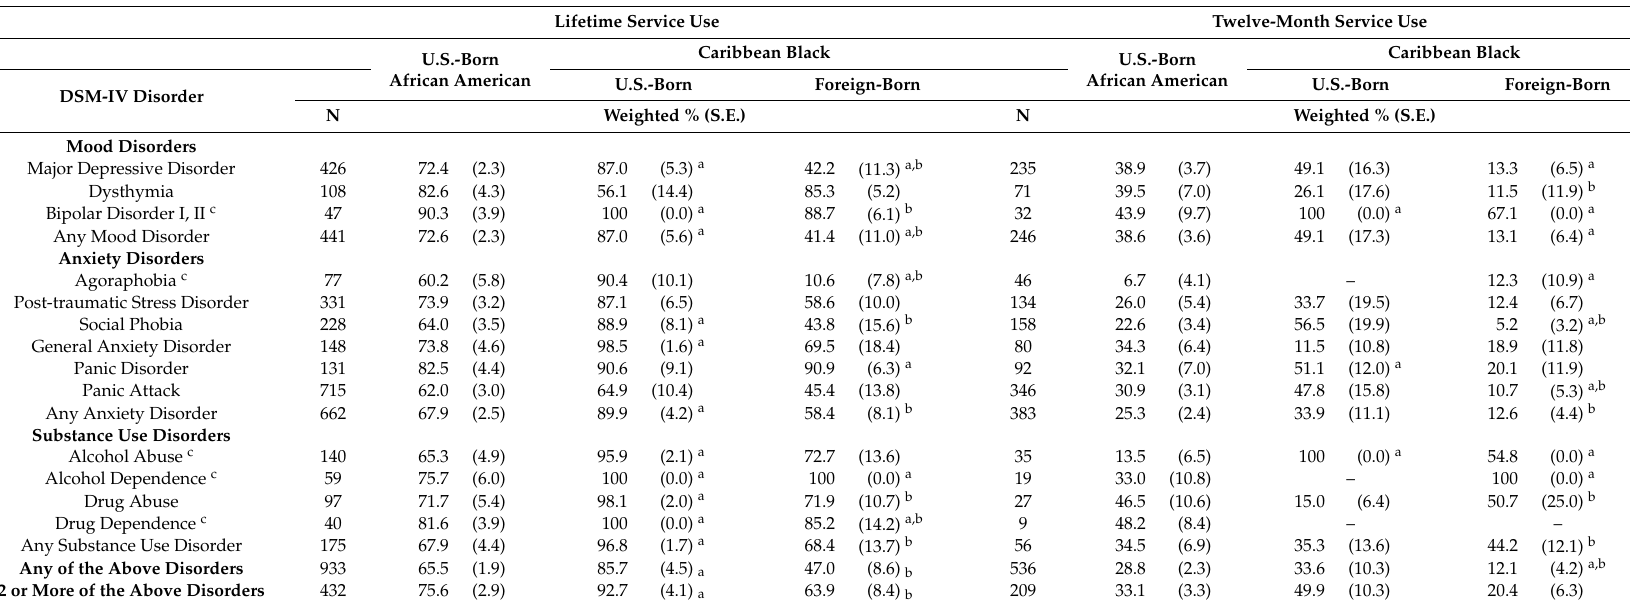
Table 5. Weighted percentages of African American vs. U.S.-born and foreign-born Caribbean Black women with a history of a DSM-IV mood, anxiety, or substance use psychiatric disorder that sought mental health